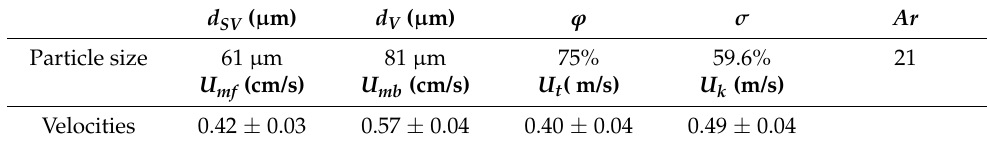
Table 1. Properties of the olivine